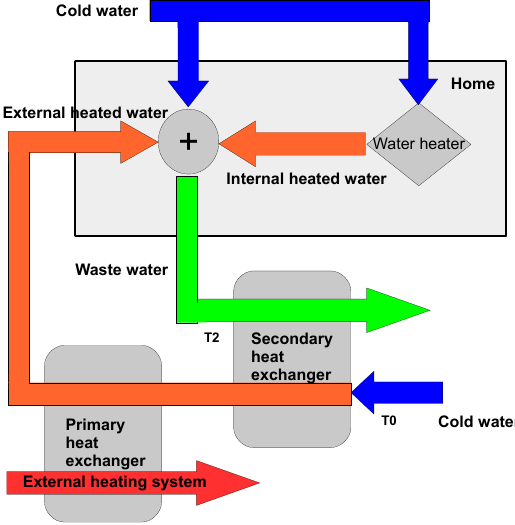
Figure 4. Energy harvest from internal and external wastewater sources.